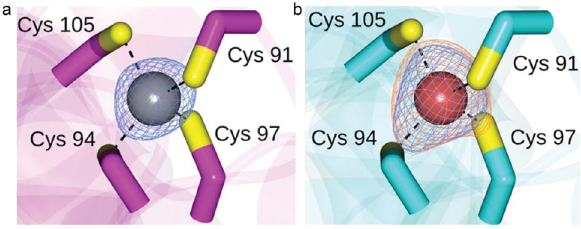
Figure 4. The Zn 2 + binding site of PyAeADHII. a) Zn 2 + binding in the active site of ADH-WT subunit A. The phased anomalous map contoured at 5 s calculated using the Zn-peak data, is shown as blue mesh. b) Metal binding site for Co-substituted PyAeADHII with the cobalt ion drawn as a red sphere. Phased anomalous difference maps contoured at 5 s were calculated using Co-peak data (orange) and Zn 2 + - peak data (blue) and revealed that both ions were present.